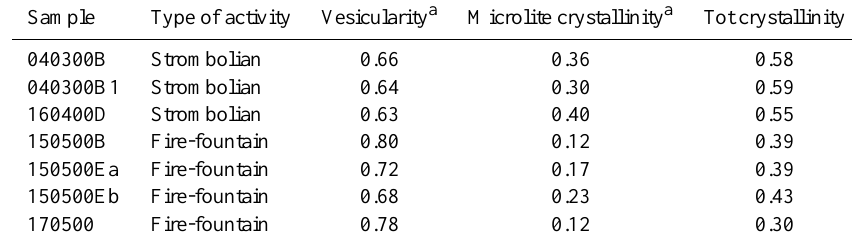
Table 1. Summary of textural features of scoriae erupted from the explosive activity at Etna in 2000. Sample Type of activity Vesicularity a Microlite crystallinity a Tot crystallinity